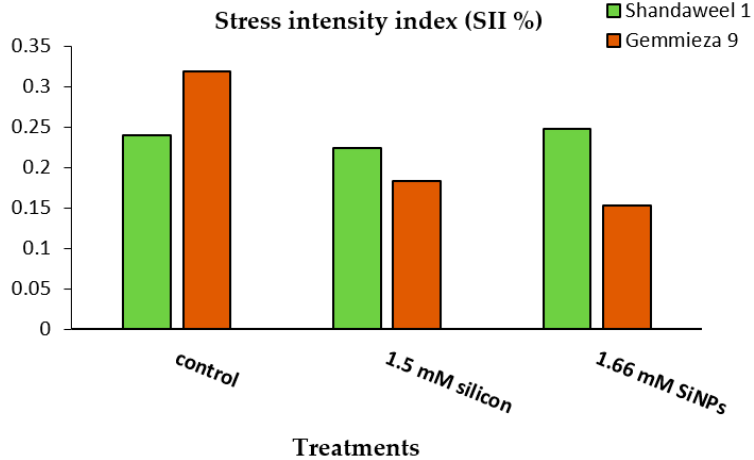
Figure 4. Effects of silicon and nanosilicon on stress intensity index (SII) of two wheat cultivars (Shandaweel 1 and Gemmeiza 9) grown under heat stress conditions.